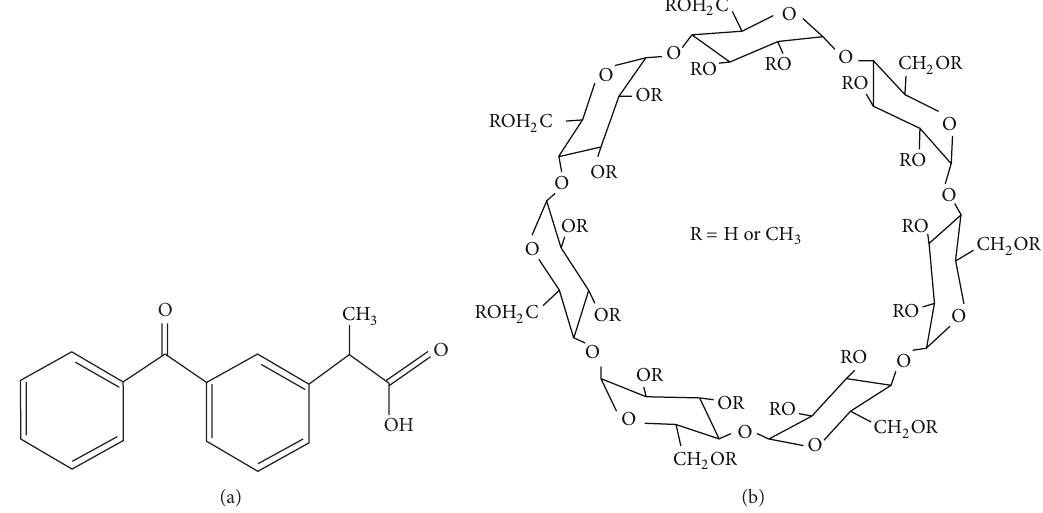
Figure2:(a)KPchemicalstructure.(b)Me 𝛽 CDchemicalstructurewithaverageMW ∼ 1310;thenumberofR=methylfunctionscorresponds